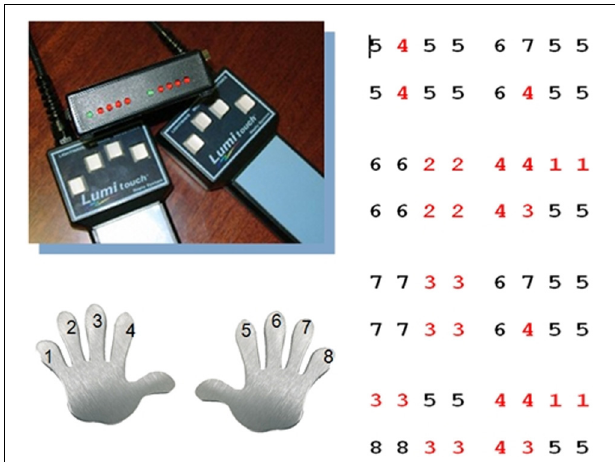
FIGURE 1 | Motor sequence task. Participants learned a motor sequence consisting of a series of key presses on two keyboards with each four keys for the left and right hand. Each digit corresponded to a key on the keyboard and thus to a finger, in ascending order from left to right, with 1 corresponding to the left and 8 to the right pinky finger (red digits: left hand, black digits: right hand). The motor sequence consisted of 64 key presses in total, subdivided into four sections with 16 key presses each. In total there were nine different 4 key